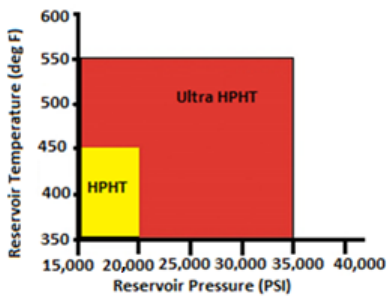
Figure 10. Defining HPHT and Ultra HPHT conditions